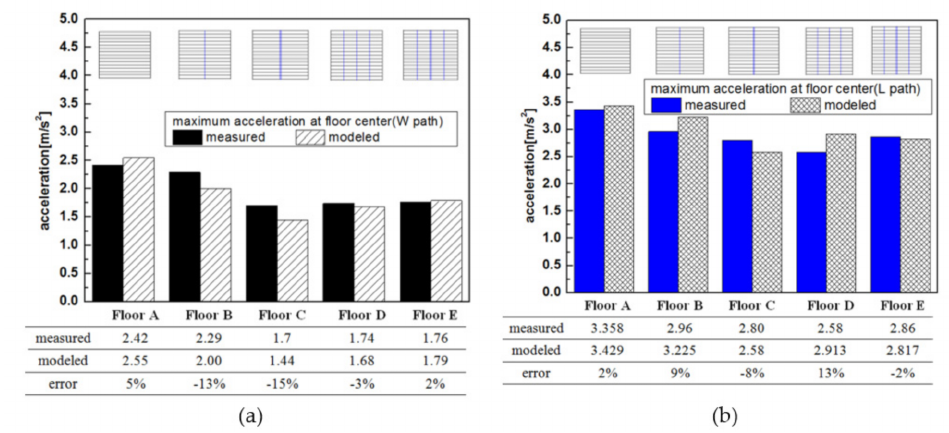
Figure 22. Tested and simulated peak acceleration at points A for the floors: ( a ) W path and ( b ) L path.